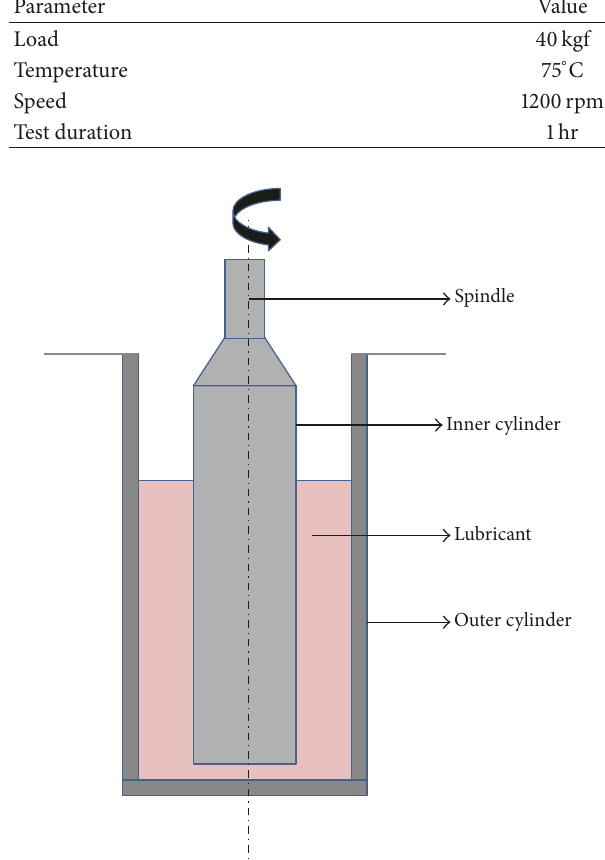
Figure 1: Concentric cylindrical geometry of